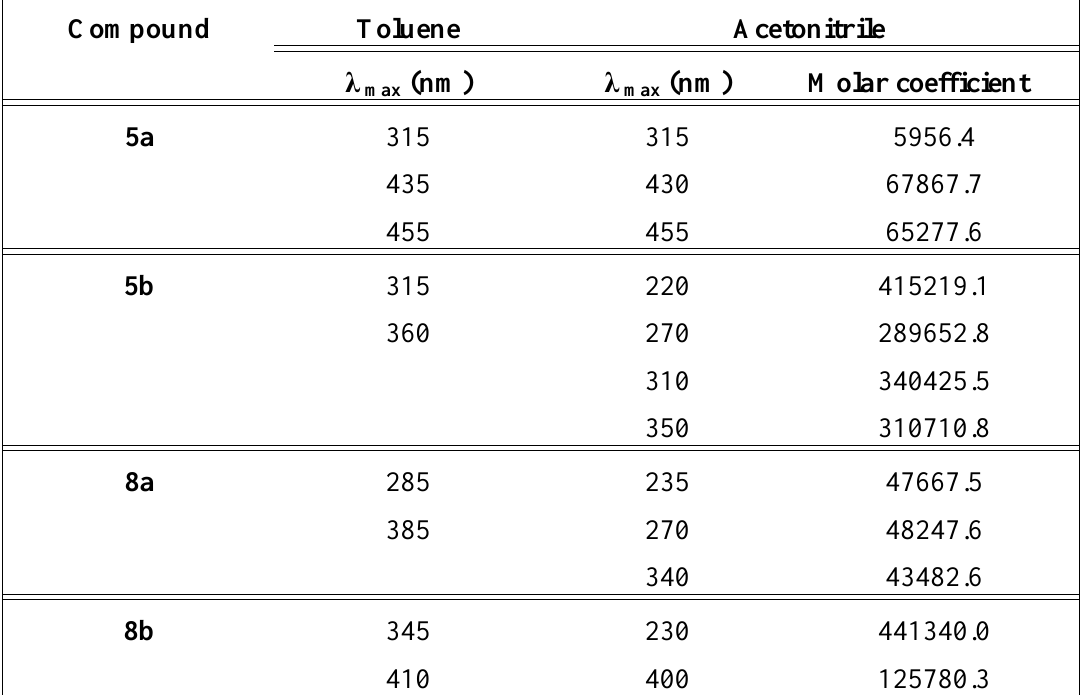
Table 1. Electronic Spectral Data of Compounds 5a-b and 8a-b